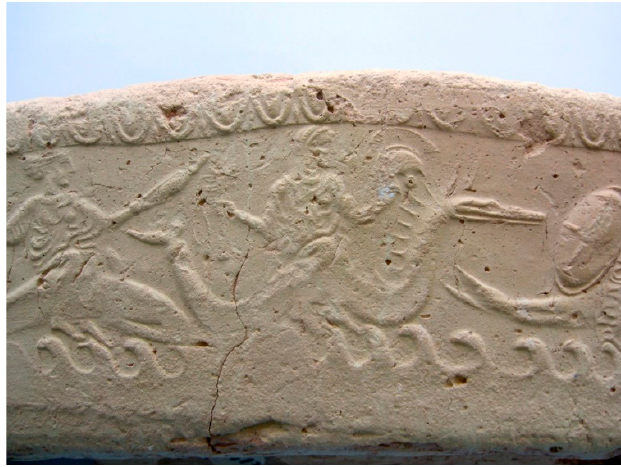
Figure 7. Nereids carrying armor on sea creatures (MGW inv. no. 768); ceramic pouring vessel ( louterion ); ca. 550–500 BCE .